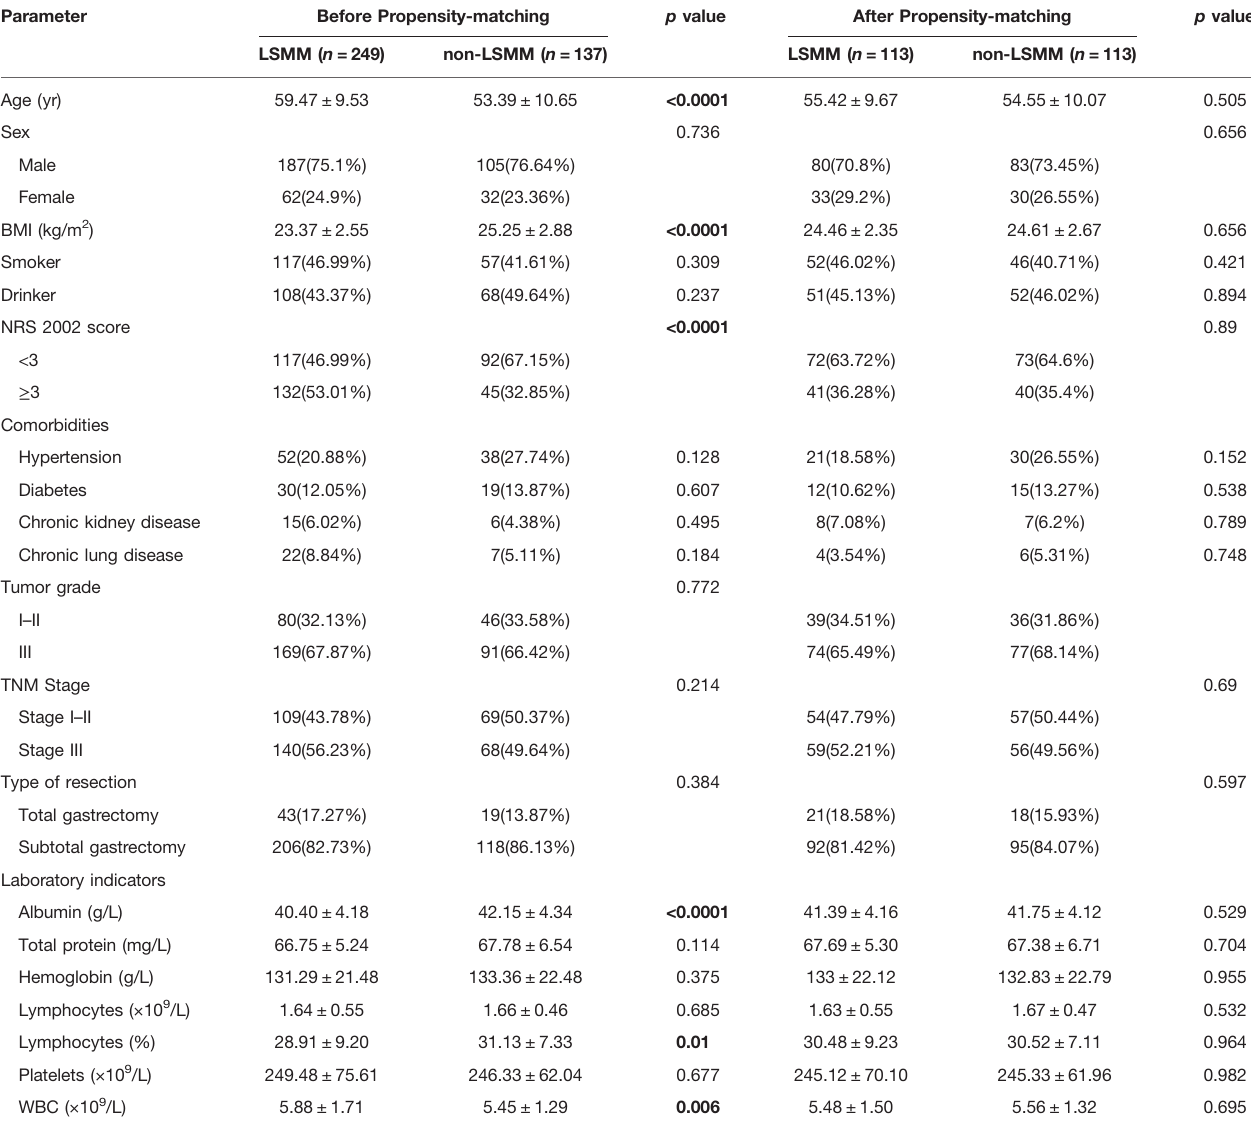
TABLE 2 | Patient demographic characteristics and clinical features before and after propensity score matching.